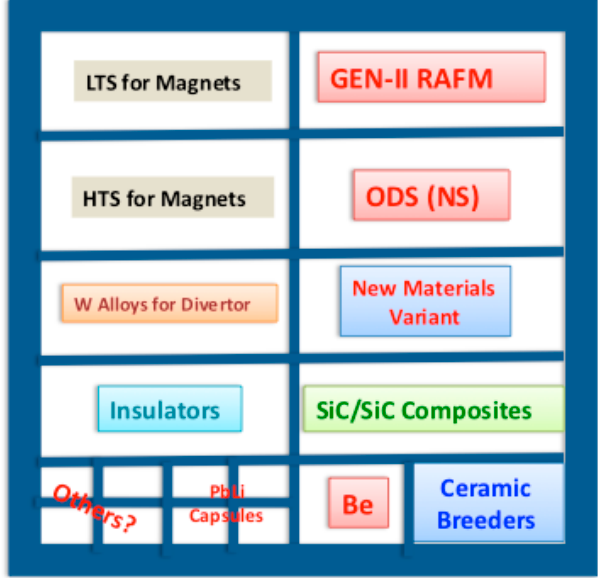
Figure 4. Layout of material samples within MTM embedded in the outboard sector of the Fusion Nuclear Science Facility.